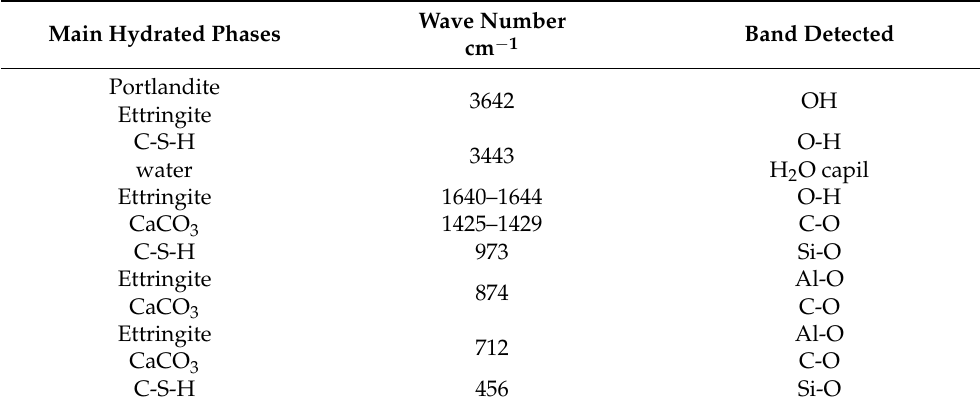
Figure 11. FTIR spectra showing reference sample (red) and after 3 h grinding (blue). Table 6. FTIR bands of the main hydrated phases.